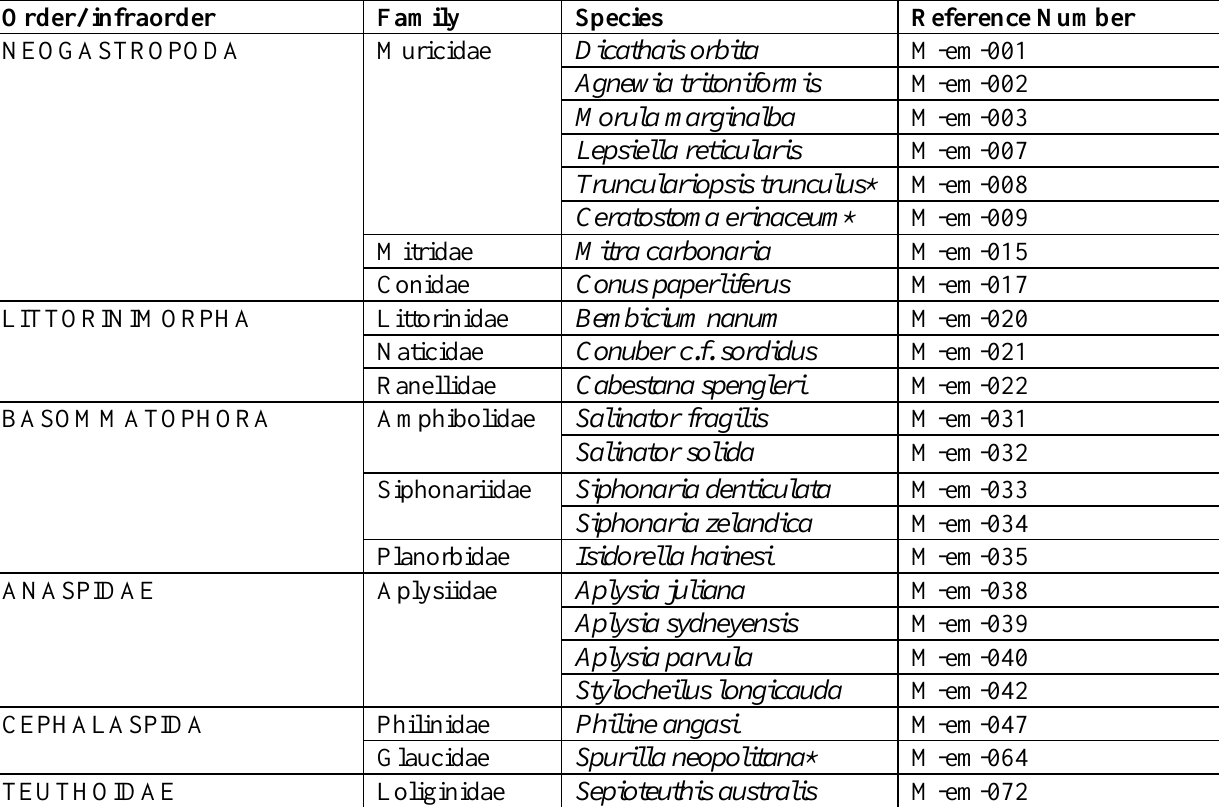
Table 2. Mollusc species selected for GC/MS examination of volatile organic chemicals in the egg mass. The reference numbers refer to samples lodged in the Department of Biological Sciences at the University of Wollongong, NSW,